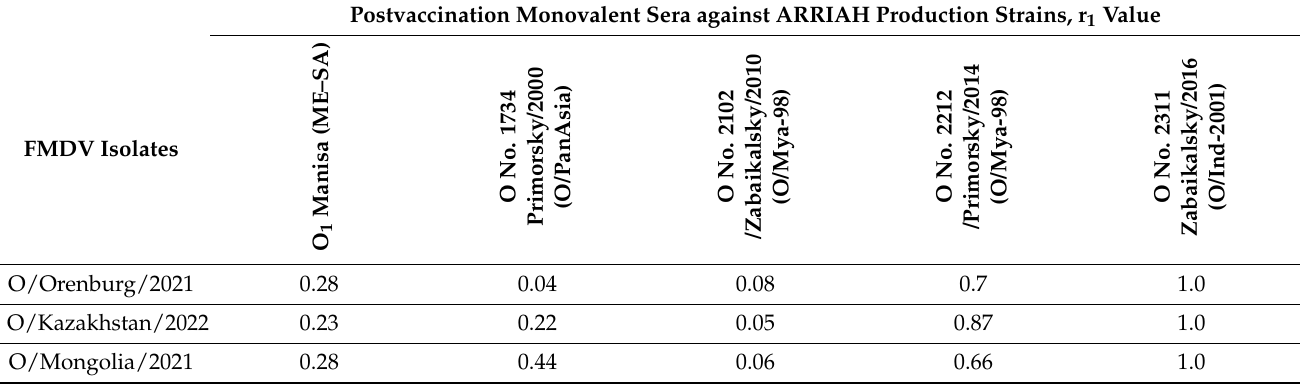
Table 2. Antigenic relationship (r 1 ) between FMDV type O isolates and production vaccine strains.